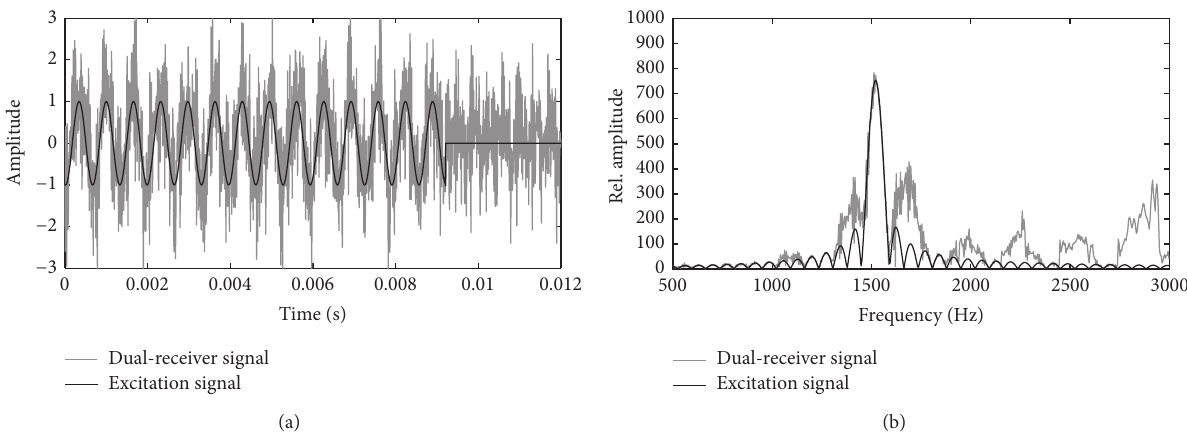
Figure 4: Simulation results of received signal in the dual-receiver mode. (a) Time-domain waveform, (b) frequency-domain waveform.